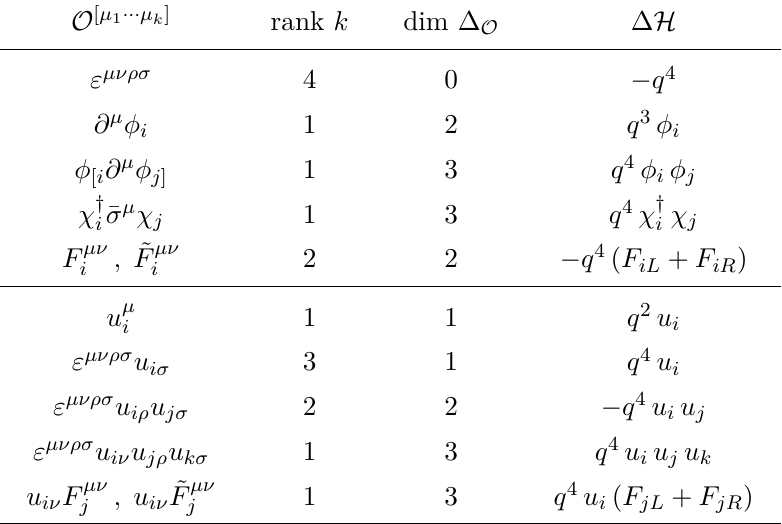
, field strengths F µν , and linearized Goldstone fields u µ i i